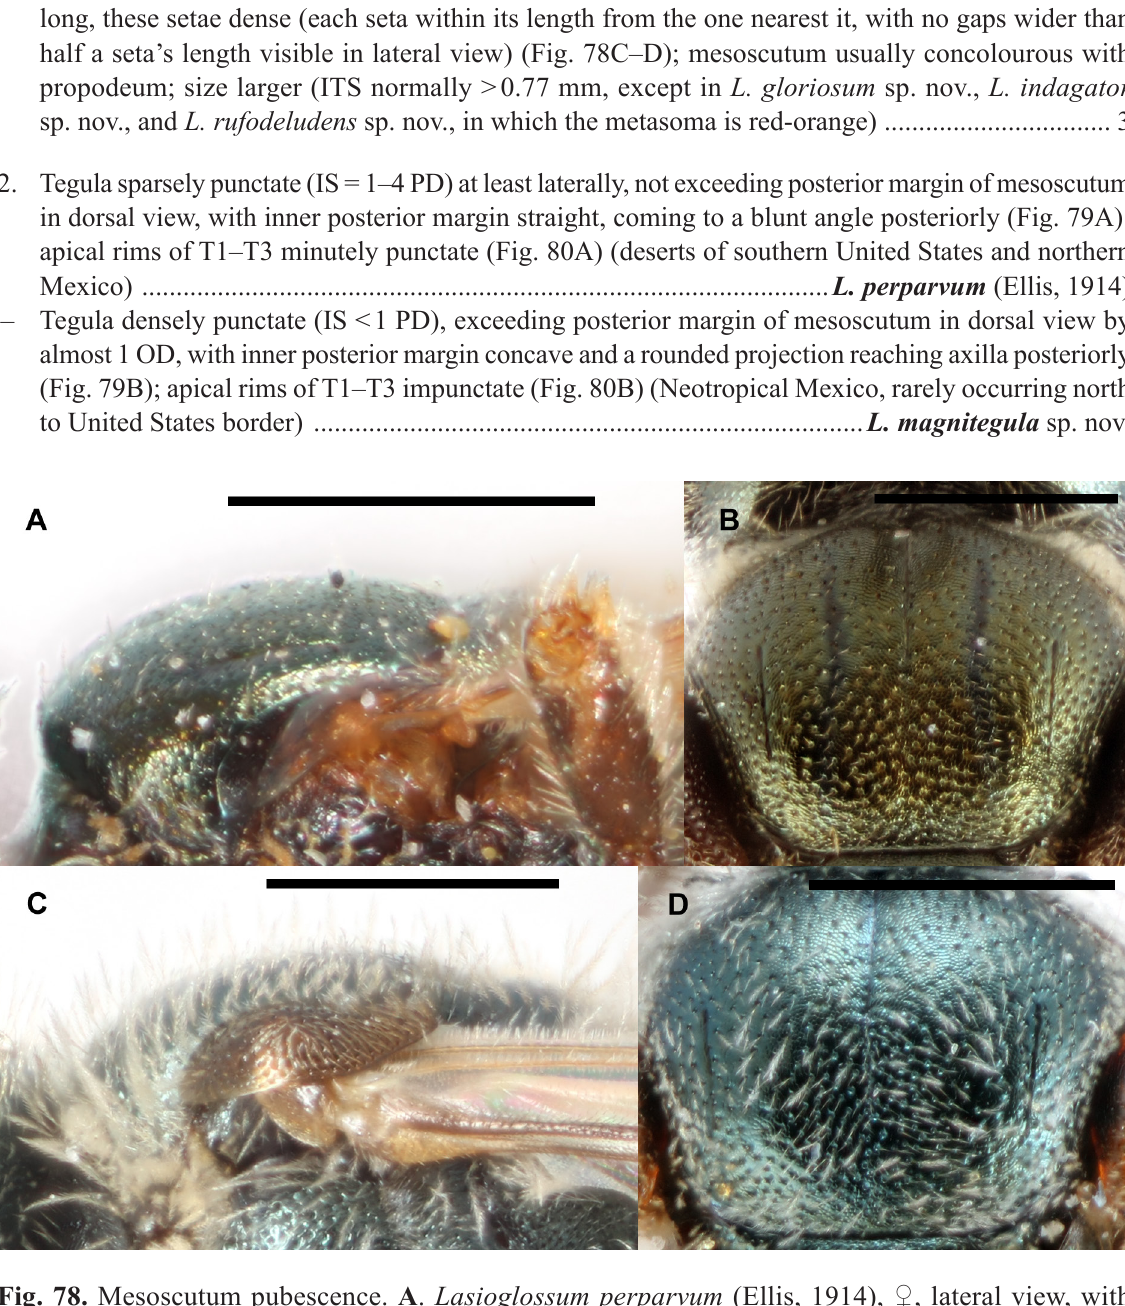
Fig. 78. Mesoscutum pubescence. A . Lasioglossum perparvum (Ellis, 1914), ♀, lateral view, with pubescence very short and sparse. B . L. magnitegula sp. nov., ♀, dorsal view, with pubescence very short and sparse. C . L. angelicum sp. nov., ♀, lateral view, with pubescence long and dense. D . L. deludens sp. nov., ♀, dorsal view, with pubescence long and dense. Scale bars = 0.5